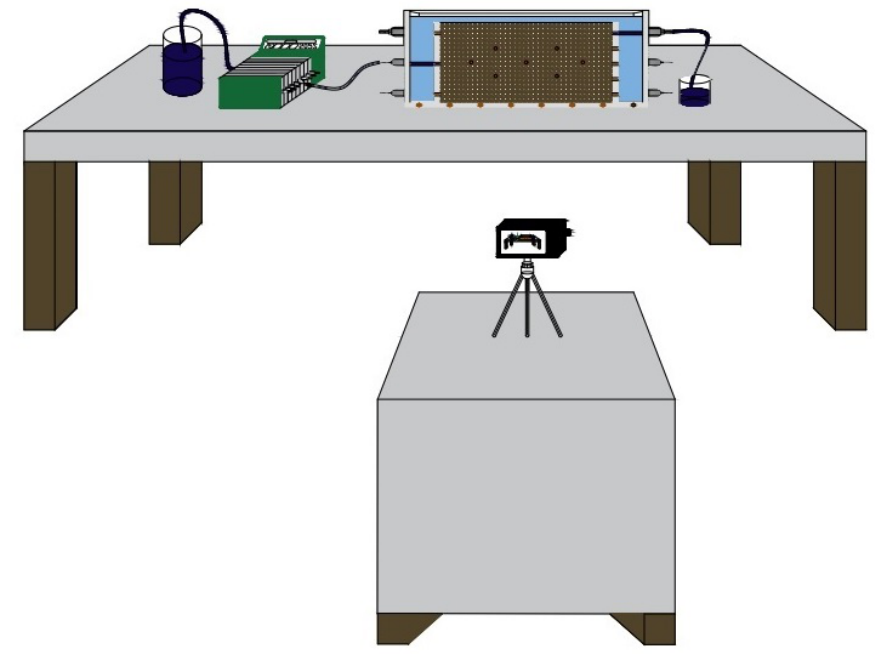
Figure 2. Schematic representation of sandbox experimental